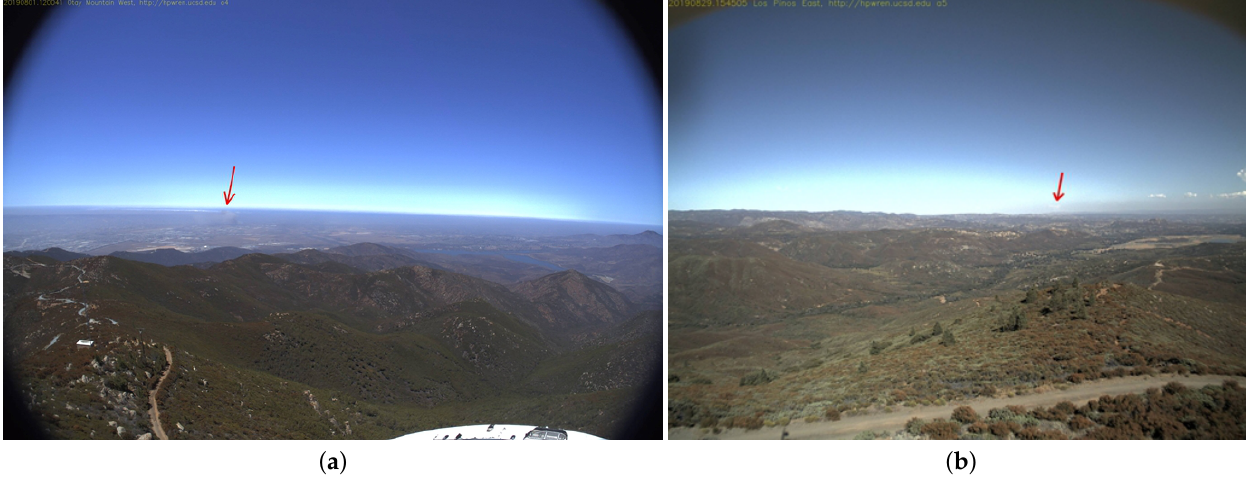
Figure 19. ( a ) Otay Mountain West fixed wide lookout camera on 1 August 2019 at 12:00. The smoke is blended into a relatively hazy background and the Pacific Ocean on the horizon. This is an interesting, anomalous test case, as the missed smoke is relatively large. ( b ) A small column of smoke visible on the horizon. Viewed from Los Pinos Mountain looking east on 29 August